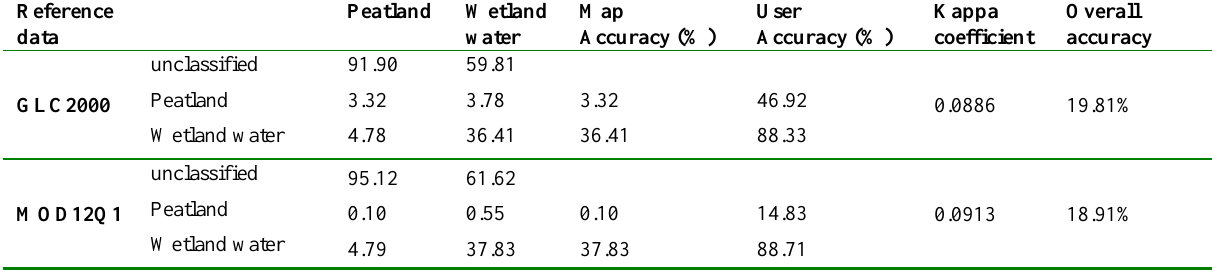
Table 3 the confusion matrix between two global landcover data sets and the reference